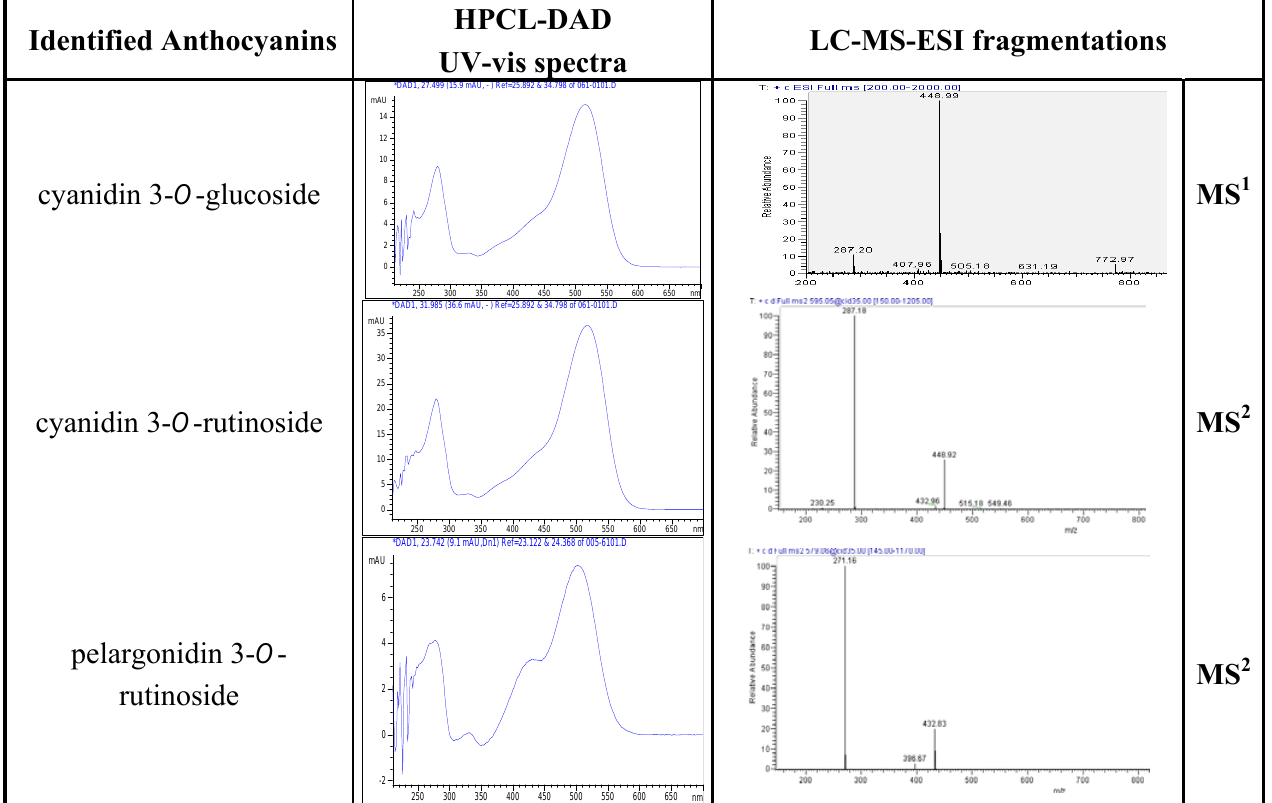
Table 2. UV-vis spectra and fragmentation analysis of Delonix regia flower extracts. Identified